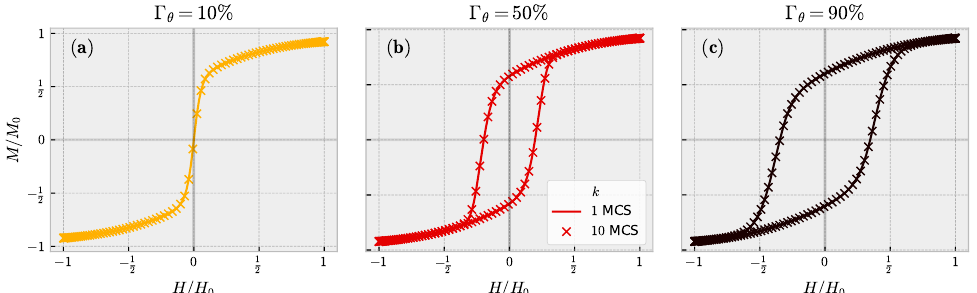
Figure A3. H-dependence of the reduced magnetization for percentages of acceptance of ( a ) 10%, ( b ) 50% and ( c ) 90%. Results without delay (i.e., every 1 MCS, which means consecutive measure- ments) are drawn with solid lines and those with a delay of 10 MCS with an x